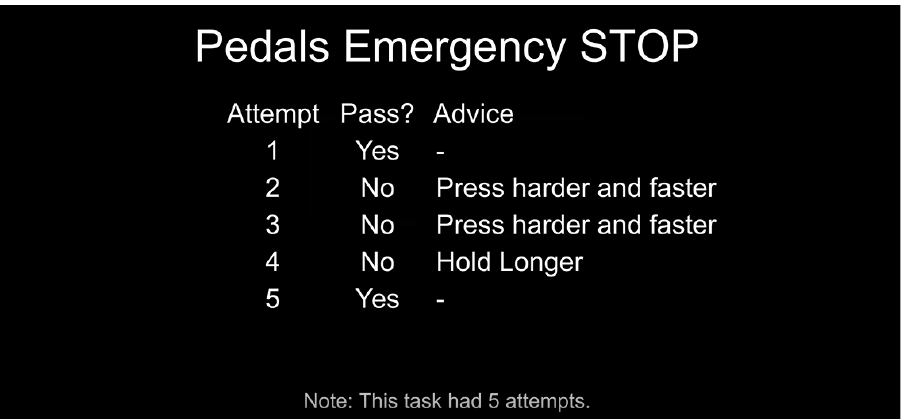
Figure 4. Example results page after all five targets of the Pedals Emergency Stop© interactive exer- cise.